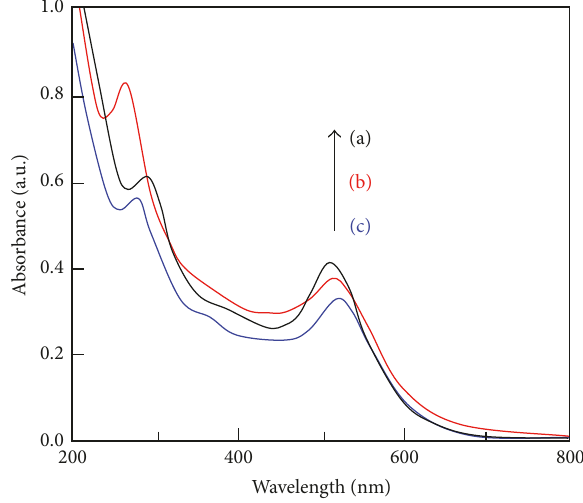
Figure 3: UV-Vis spectra of AuNPs/dextran solutions with various Au 3+ concentrations: 0.5 (a), 1.0 (b), and 2.0 mM